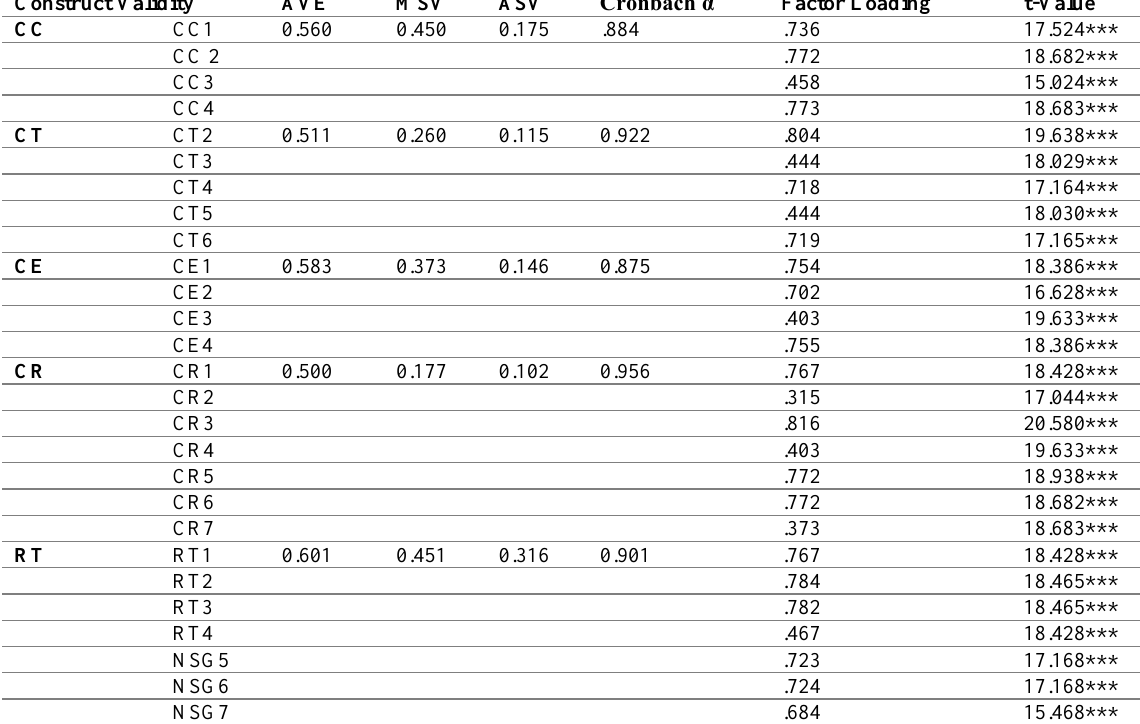
Table 4: Overall reliability of the constructs and CFA loadings of